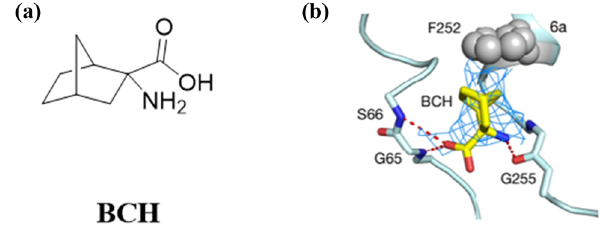
Figure 7: ( a ) Structure of BCH and ( b ) schematic diagram of BCH binding sites.